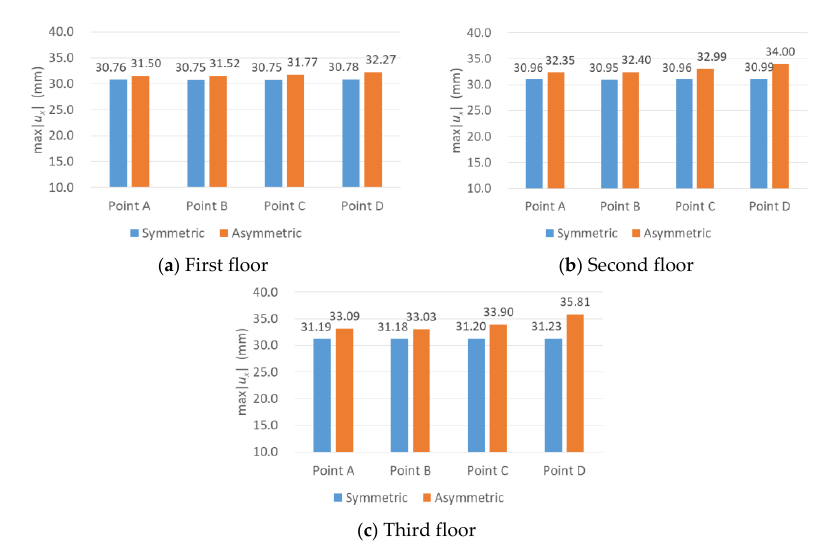
Figure 38. Absolute maximum displacement in the x -direction of the asymmetric and the hypothetical symmetric structures due to the Northridge earthquake (Run 19).